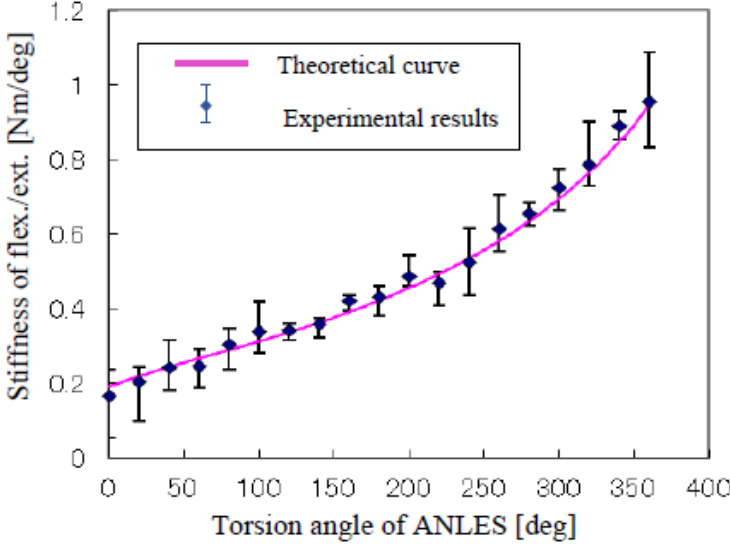
Figure 11. Stiffness about flexion/extension of the elbow joint.